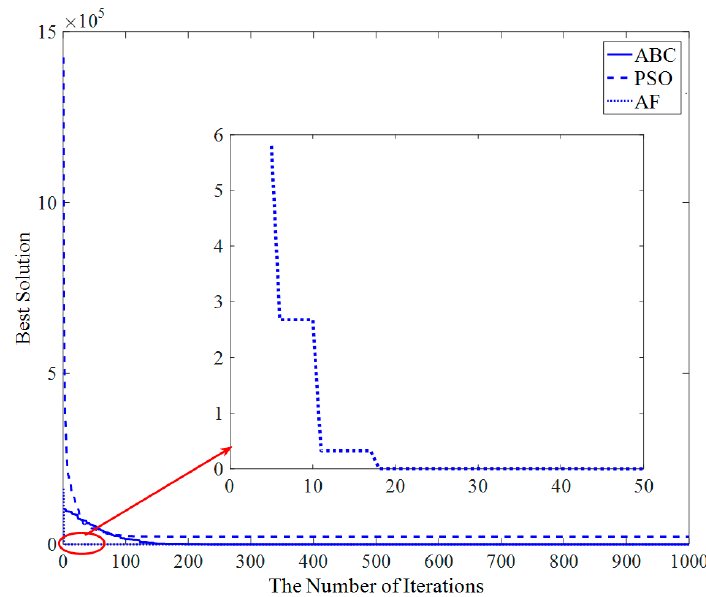
Figure 9. The convergence curve of the three algorithms for Sphere function in 50-dimensional space. PSO: particle swarm optimization algorithm; ABC: artificial bee colony algorithm; AF: artificial flora algorithm.